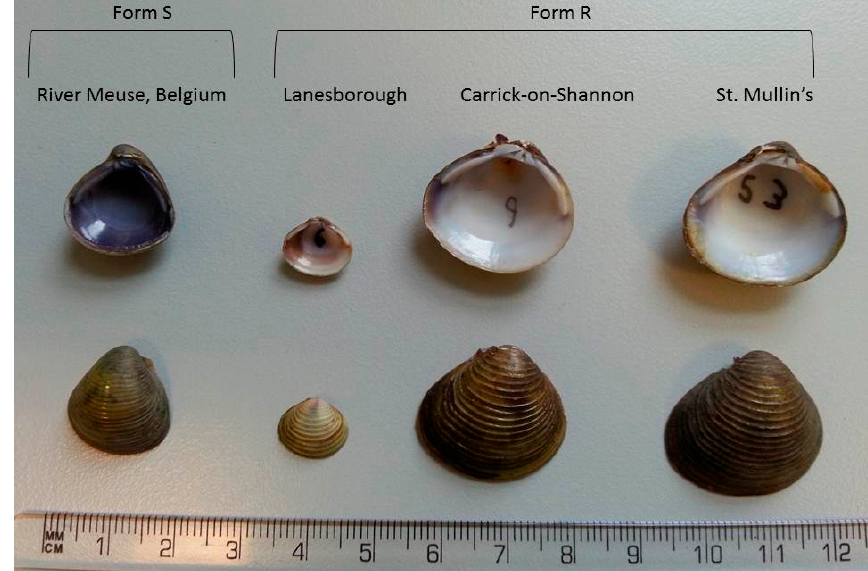
Figure 2. Examples of Corbicula form R from the River Shannon at Lanesborough (juvenile specimen) and Carrick-on-Shannon and the River Barrow at St. Mullin’s. Also shown is an example of Form S from the River Meuse at Maastricht.